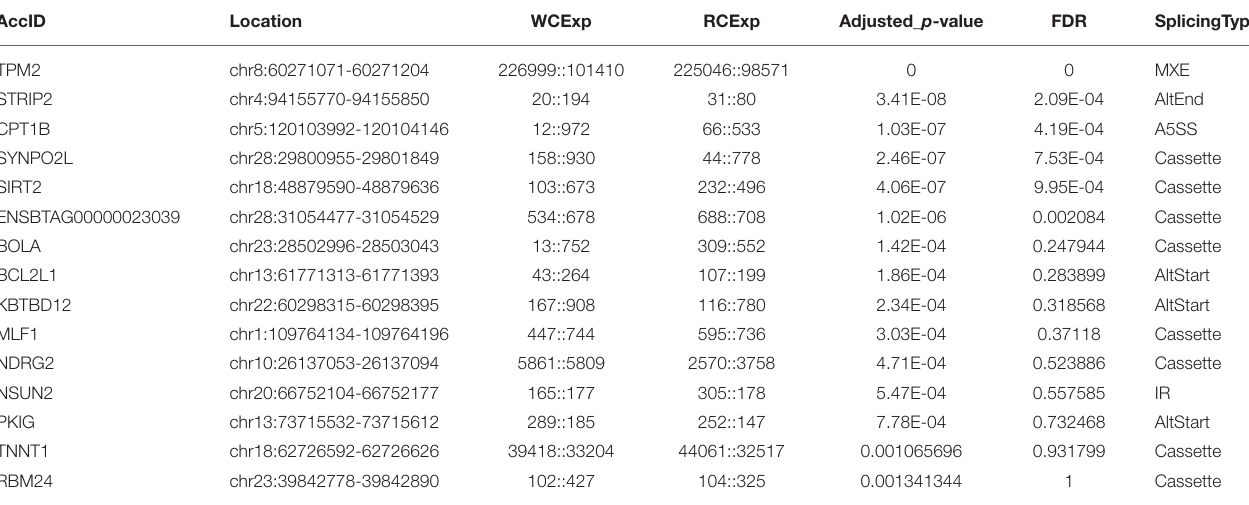
TABLE 2 | Top 15 differentially expressed alternatively spliced genes between Japanese Black cattle and Chinese Red Steppes.